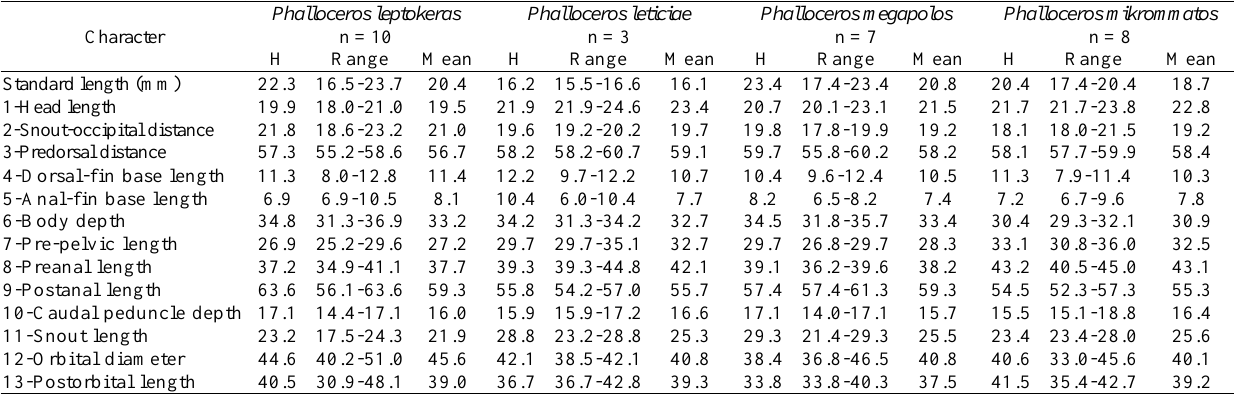
Table 2. Descriptive morphometrics of male specimens of Phalloceros leptokeras , P . leticiae, P . megapolo s, and P . mikrommatos . Measurements 1-10 are percents of standard length and measurements 11-13 are percents of head length. H = holotype.